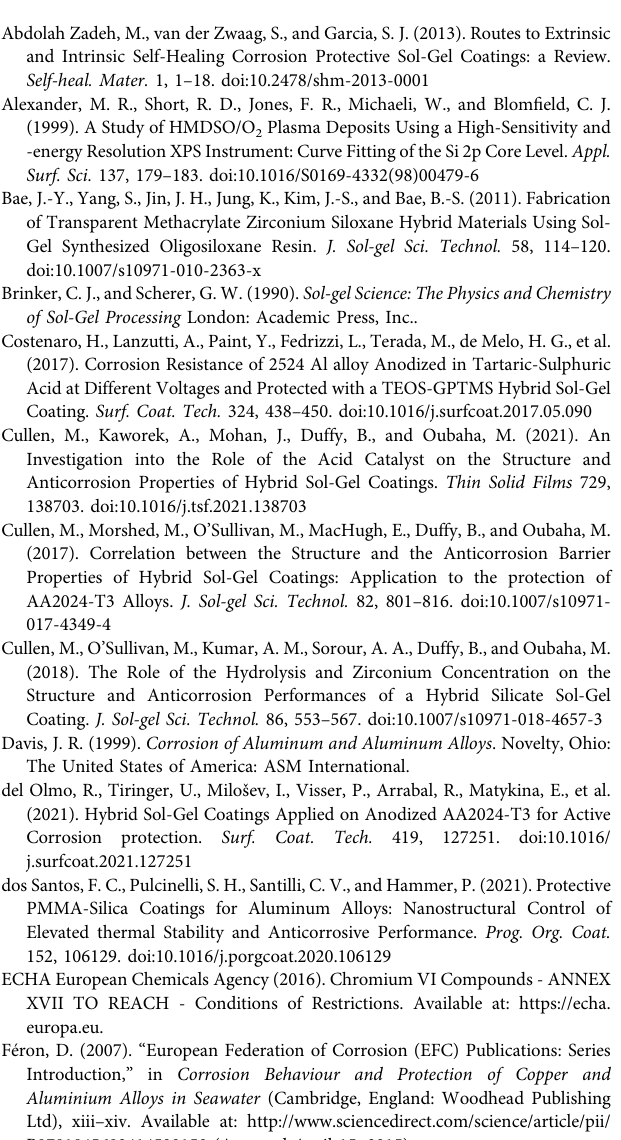
Figueira,R.B.(2020).HybridSol-GelCoatingsforCorrosionMitigation:ACritical Review. Polymers 12, 689.